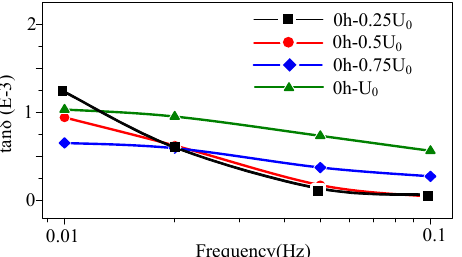
Figure 8. High-voltage FDS of the unaged cable (aging time 0 h). According to the microscopical physicochemical test results, the aging degrees are divided into three phases: the early, middle, and late aging stages. The high-voltage FDS curves of the cable at the early aging stage (48–92 h) are shown in Figure 9a,b. The FDS curve shapes of the unaged and early aging stage cable are similar, but the tan δ values show an increasing trend. In addition, the tan δ of the early aging stage cable increases as the detection frequency decreases, indicating the slope of the tan δ -f curves increase compared to the unaged cable. However, at this aging time point, the cable is still at the stage of early aging, the increase in dielectric loss is not large, and there is no regular variation in the change in voltage level. Correspondingly, the performance changes are not obvious. As shown in Table 1, the EAB, CI, and crystal structure exhibit almost no change.